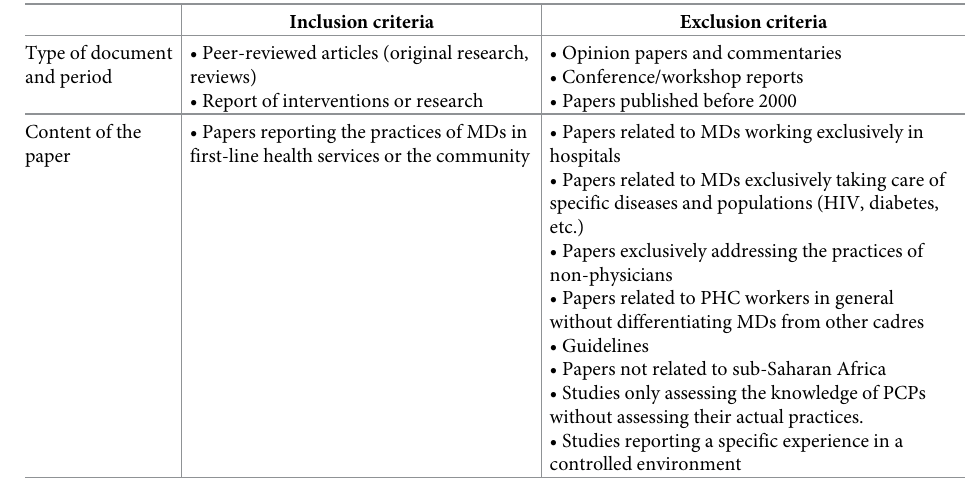
Table 1. Selection